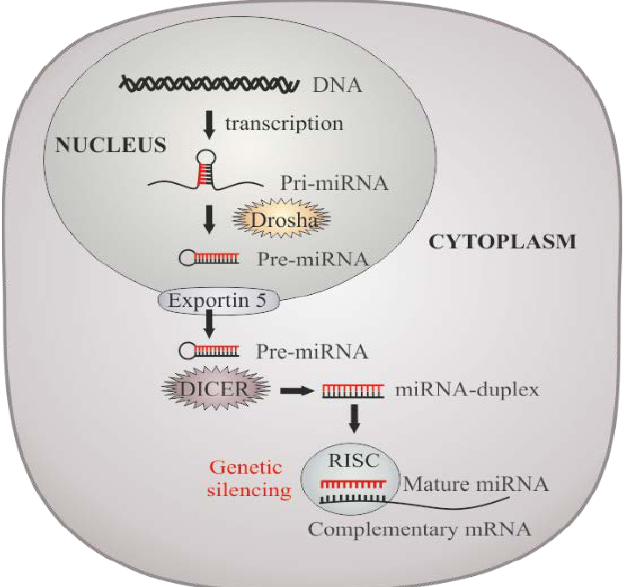
Figure 4. miRNAs biogenesis and molecular processing/action. Pri-miRNAs are synthesized in the nucleus, recognized and cleavage by Drosha into a smaller stem-looped structure–the pre-miRNA. Pre-miRNAs are then transported into the cytoplasm for further processing by Dicer, originating the mature miRNAs, which will integrate the miRISC. Genetic silencing or block of translation will depend on the level of homology between miRNAs and their complementary target sequences primarily located within 3′ -UTRs of mRNAs.